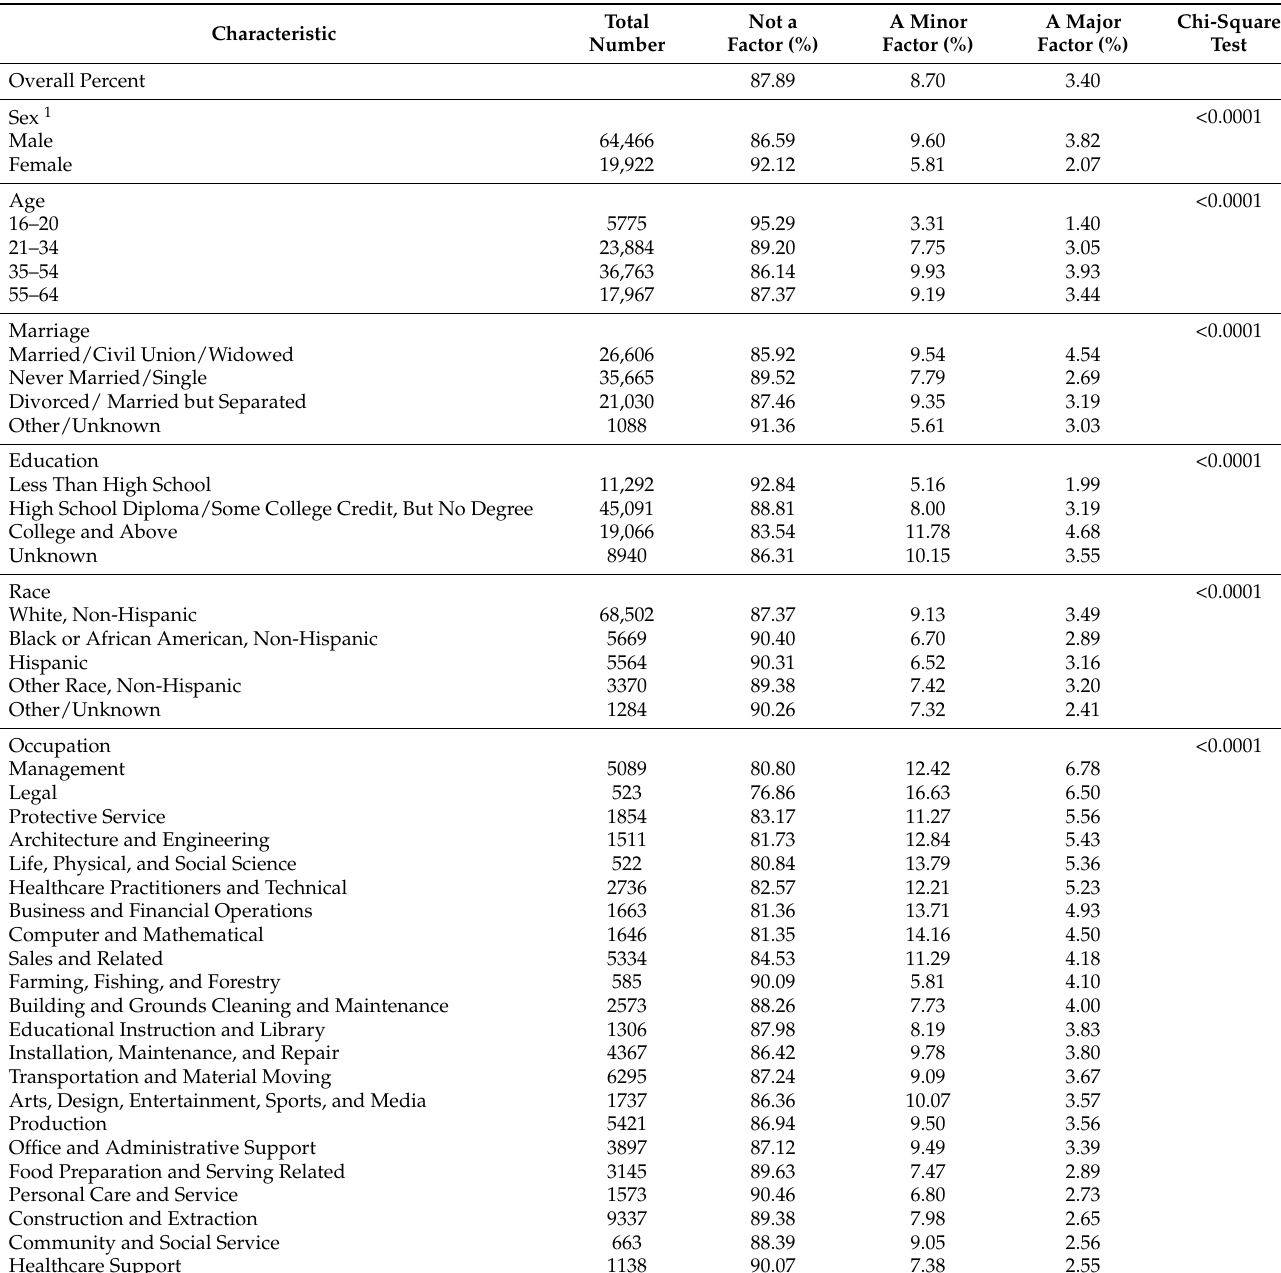
Table 2. Proportion of suicides for which work was a minor, major, or not a contributing factor, by demographic characteris- tics, National Violent Death Reporting System, 2013 through